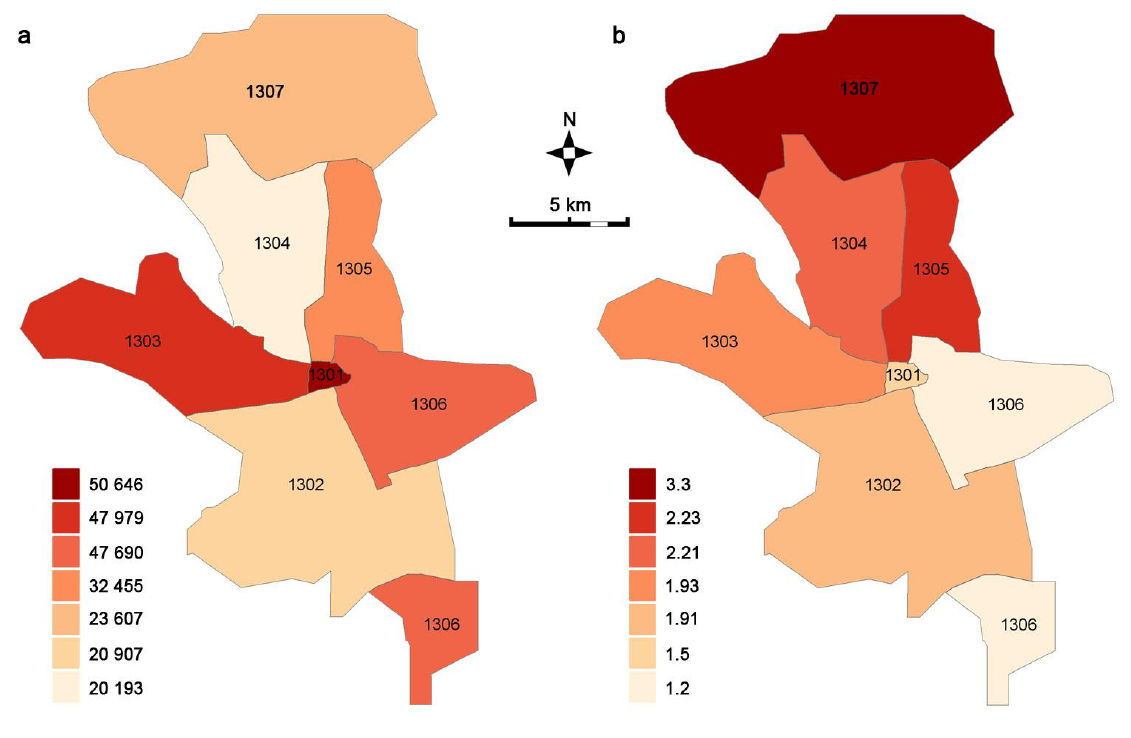
Figure 10. Population density per built-up area of each district [Population / km 2 ] for 2007 ( a ), and changes of population density per built-up area of each district between 2007 and 1994 displayed as ratio ( b